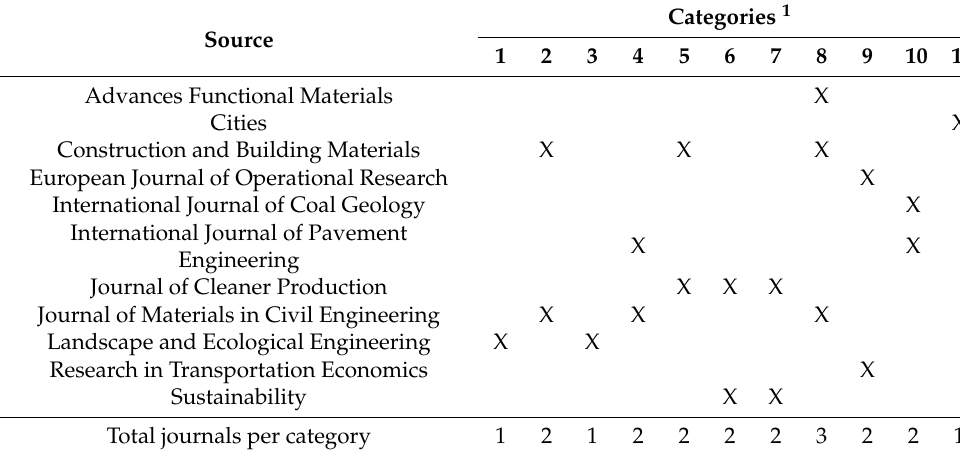
Table 2. Categories of the sources leading the